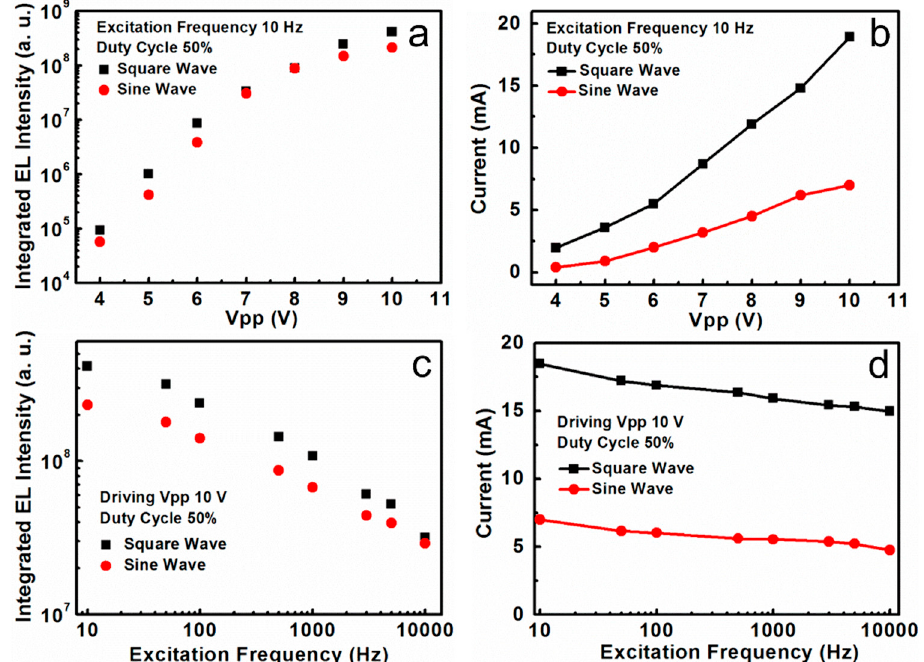
Figure 5. ( a ) The integrated EL intensity versus Vpp (from 4 to 10 V) with 10 Hz excitation frequency and 50% duty cycle under different driving voltage modes (square wave and sine wave); ( b ) Current versus Vpp for the devices under square pulsed bias and sine pulsed bias with 10 Hz excitation frequency and 50% duty cycle; ( c ) The integrated EL intensity versus excitation frequency (from 10 Hz to 10 kHz) with 10 V driving voltage and 50% duty cycle under different driving voltage modes (square pulsed bias and sine pulsed bias); ( d ) Current versus excitation frequency for the devices under square pulsed bias and sine pulsed bias with 10 V Vpp and 50% duty cycle.